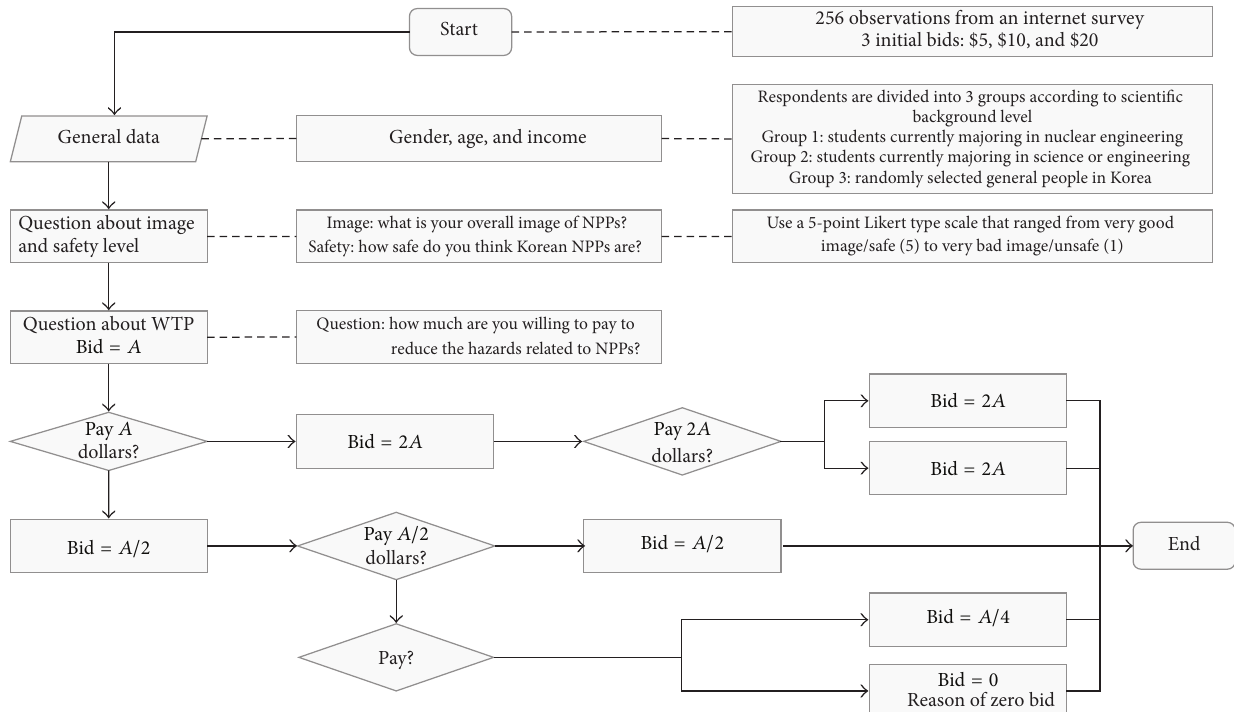
Figure 1: Logical process of the questionnaire used for the CVM